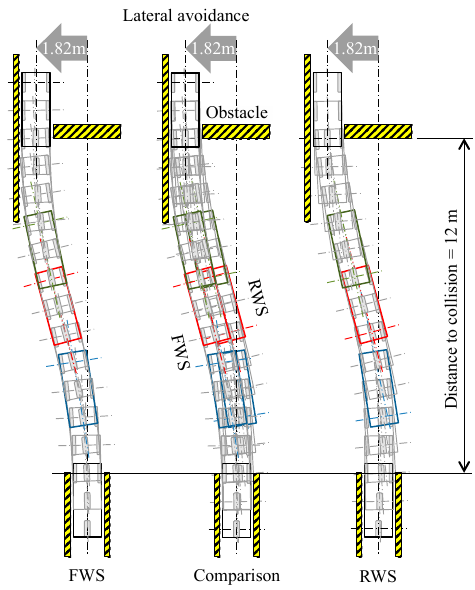
Figure 18. Tracks image of front wheel steering (FWS) and rear wheel steering (RWS) to avoid obstacle.